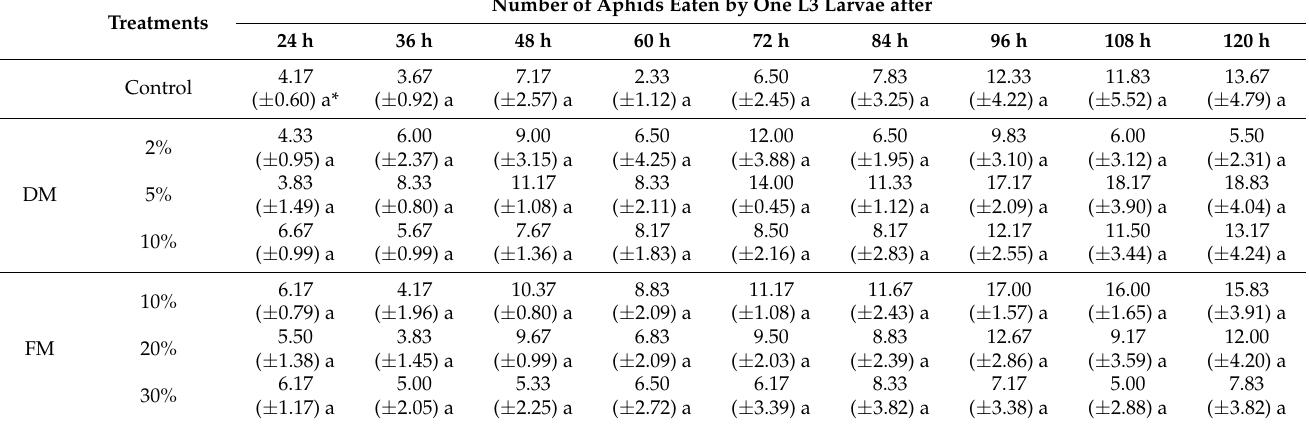
Table 4. Number of aphids eaten by one L3 larvae of Coccinella septempunctata L. after the application of water extracts made from the fresh (FM) and dried (DM) parts of